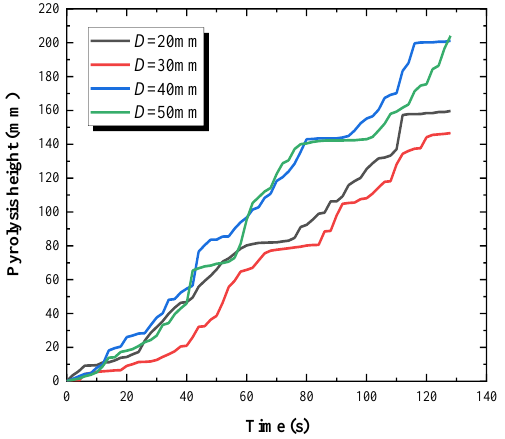
Figure 4. Pyrolysis height versus time.